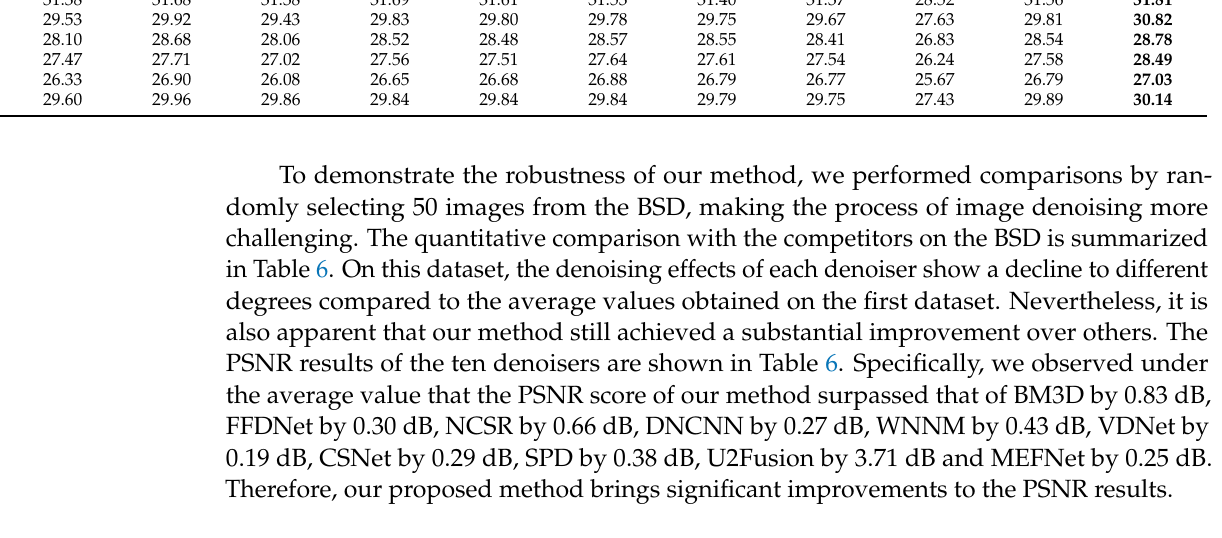
Table 6. Average performance of various methods on BSD with different noise